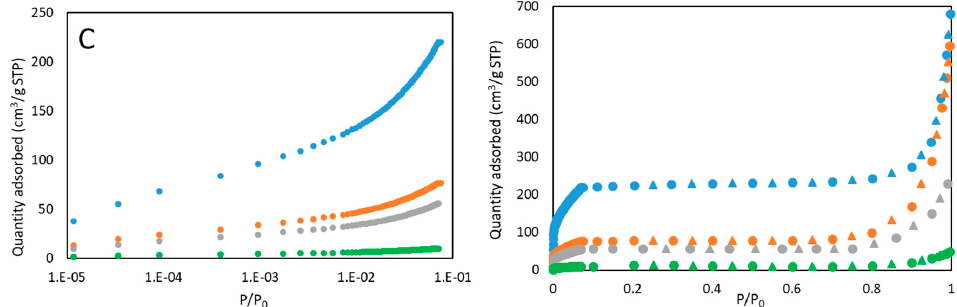
Figure 4. Adsorption ( ● ) and desorption ( ▲ ) N 2 isotherms (77 K). Basolite C300 ( A ), Basolite F300 ( B ) and Basolite A100 ( C ). Original sample (Blue), 55.9 MPa (Orange), 111.8 MPa (Grey) and 186.3 MPa (Green). The graphs on the left are zoom of the low pressure zone (up to P / P 0 = 0.1) on logarithmic scale. Table 1. Variations of Brunauer–Emmett–Teller (BET) surface area, Barrett–Joyner–Halenda (BJH) total mesopore volume, t -plot total micropore volume and average pore size with applied pressure.